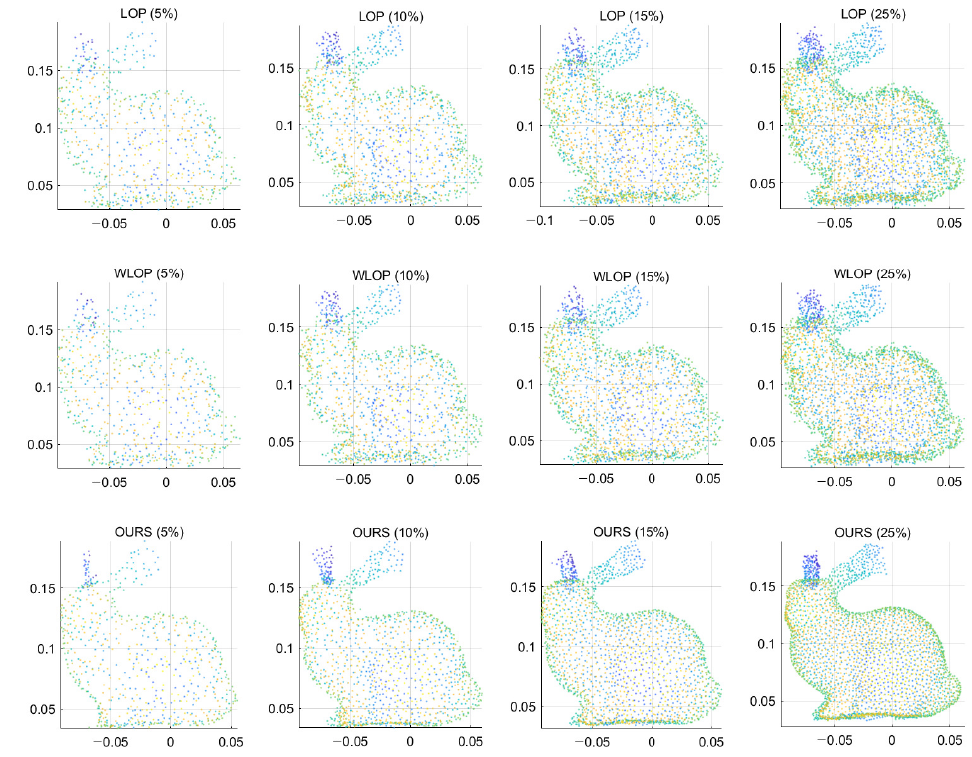
Figure 23. Resampling results of low-density inputs. The input point clouds were generated by randomly subsampling the input data of Figure 5. The percentages in the parentheses represent the amount of subsampling. First row: LOP, second row: WLOP, and third row: proposed method.